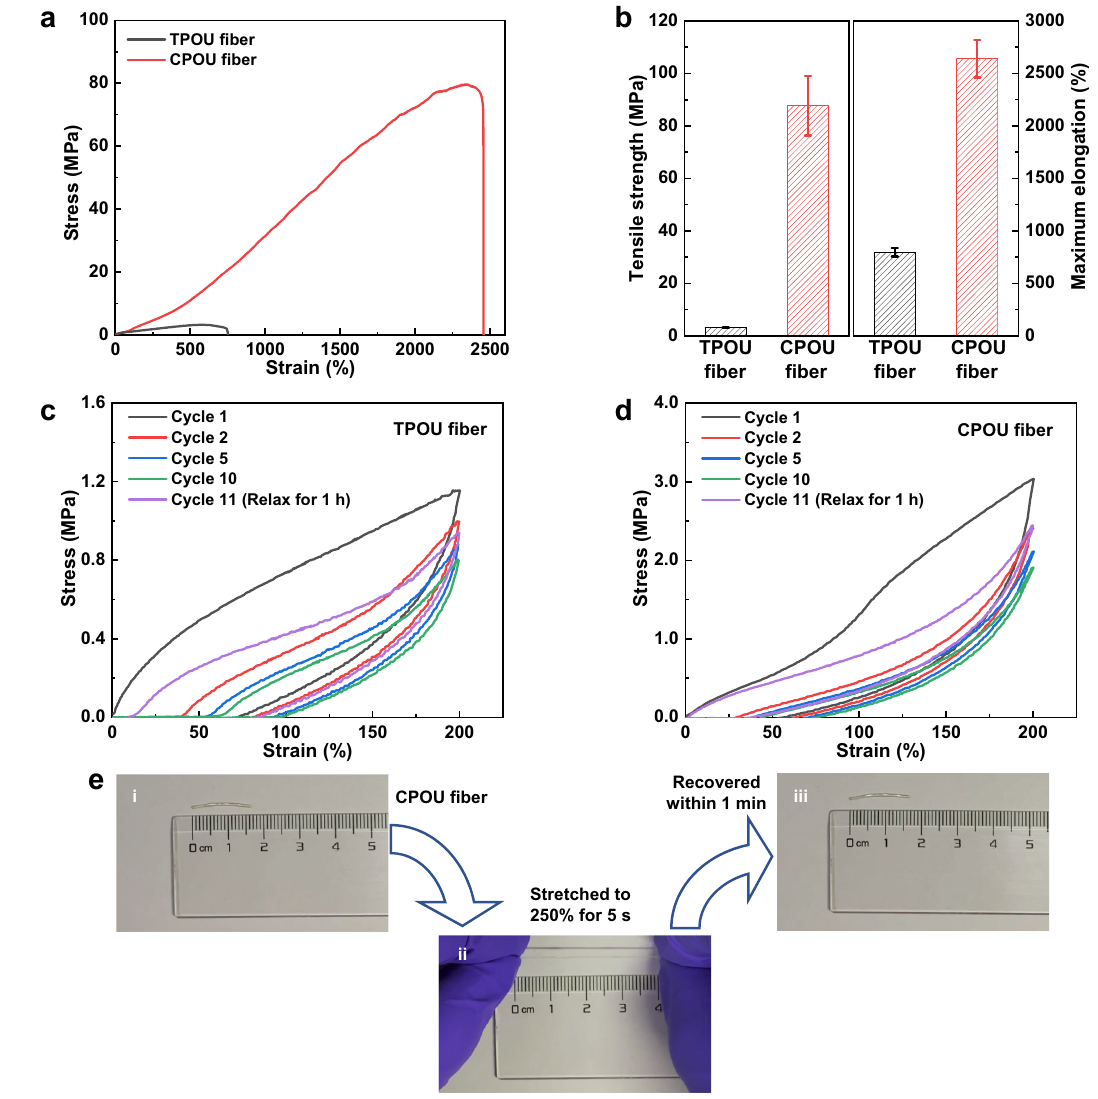
Fig. 3 | Mechanical properties ofTPOUand CPOU fi bers.a Typicaltensilestress- strain curves. b Comparison of their tensile strength and maximum elongation (error bars: standard deviations). c , d Cyclic tensile curves of c TPOU fi ber and d CPOU fi ber at 200% strain. There was no break between each consecutive cycle